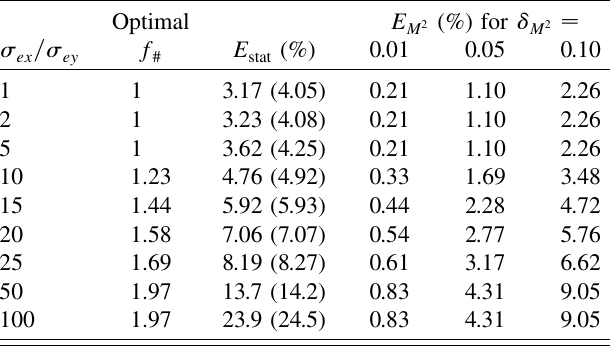
TABLE VI. Optimal f -numbers (for E and the corresponding statistical precision for (cid:2) ment of (cid:2) ey 1 (cid:3) m , (cid:13) (cid:1) 355 nm , and M 2 (cid:1) 1 : 3 . The minimum